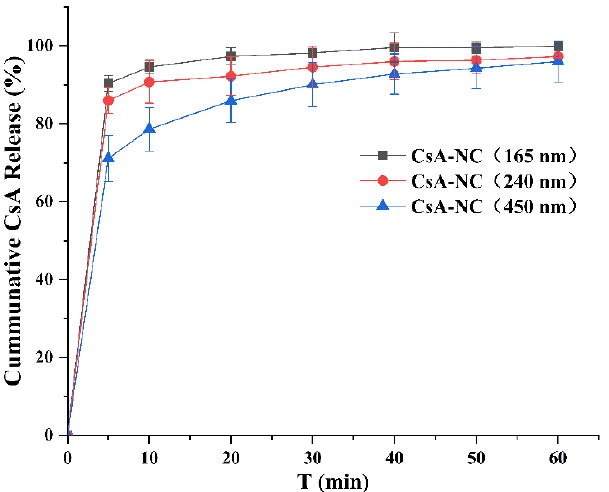
Figure 3. Dissolution profiles of CsA-NCs in HBSS containing 0.01% SDS. ( n = 3, means ±